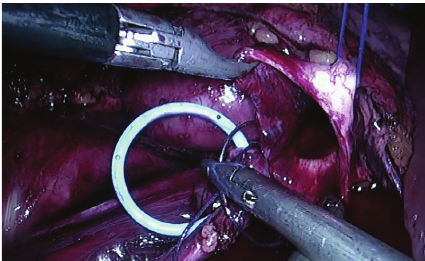
Figure 2: The renal pelvis after dissection.